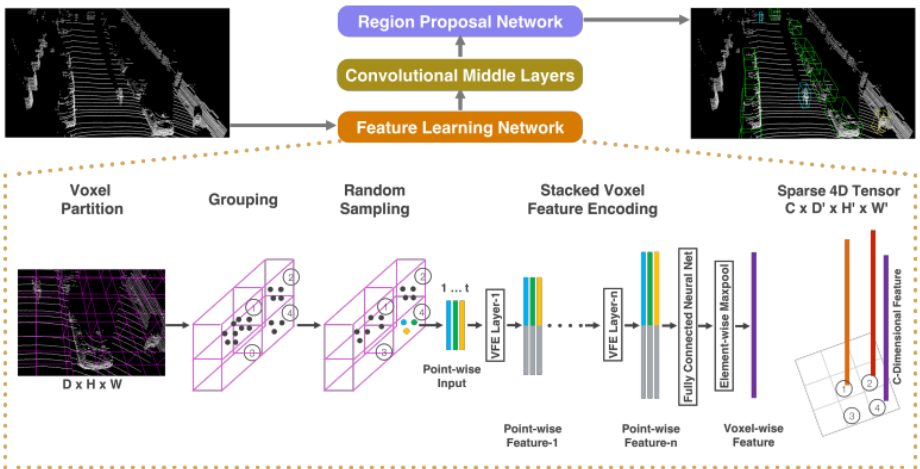
Figure 1. The early fusion